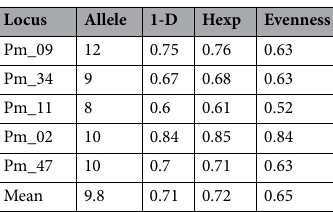
Table 4. Summary statistics of microsatellite loci showing genotypic richness, diversity, and evenness by locus. 1-D Simpson’s diversity Index, Hexp Nei’s unbiased gene diversity.